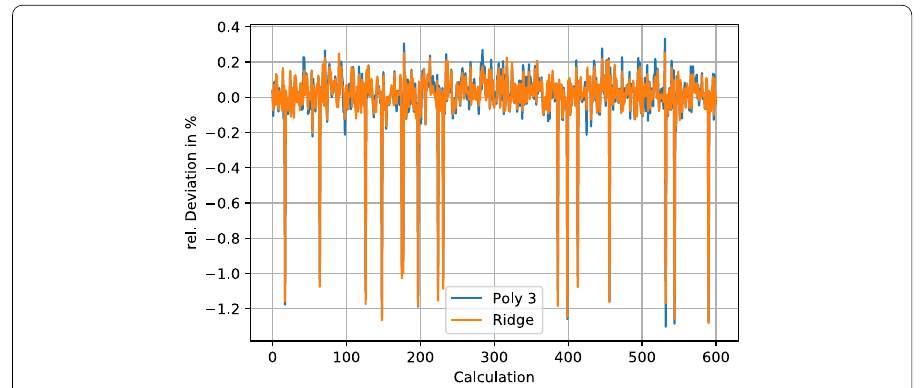
Fig. 17 Brakedisk comparison of ridge-regression to polynomial third order